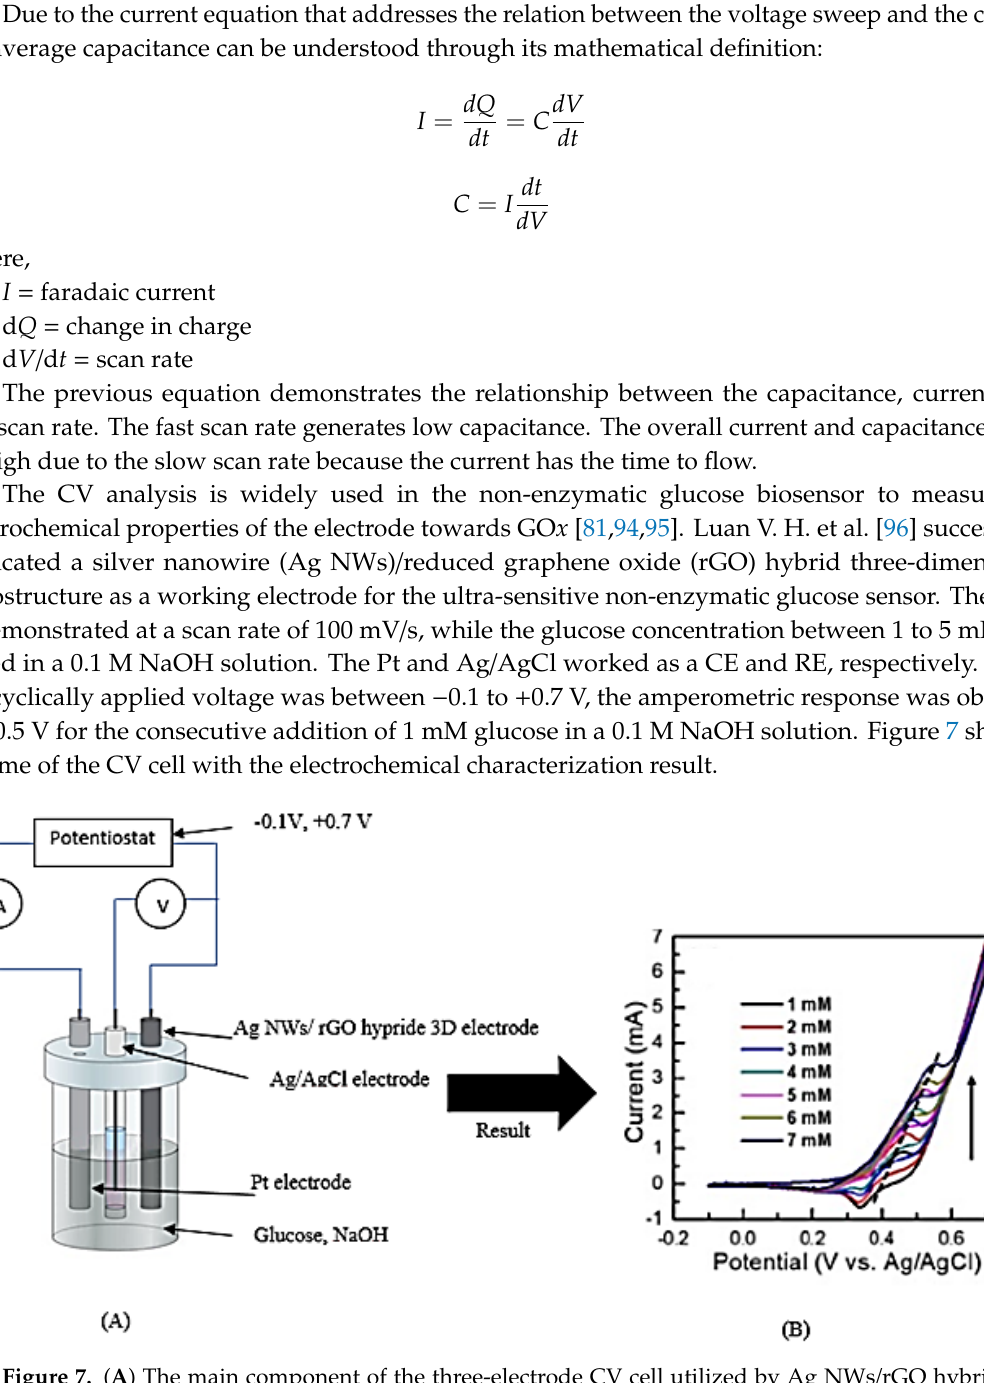
Figure 7. ( A ) The main component of the three-electrode CV cell utilized by Ag NWs/rGO hybrid three-dimensional (3D) electrode as a working electrode, Ag/AgCl as a reference electrode, and Pt electrode as a counter electrode, for glucose detection. ( B ) Results of the sensor with a full description of the oxidation peak and reduction peak at a scan rate of 100 mV/s.